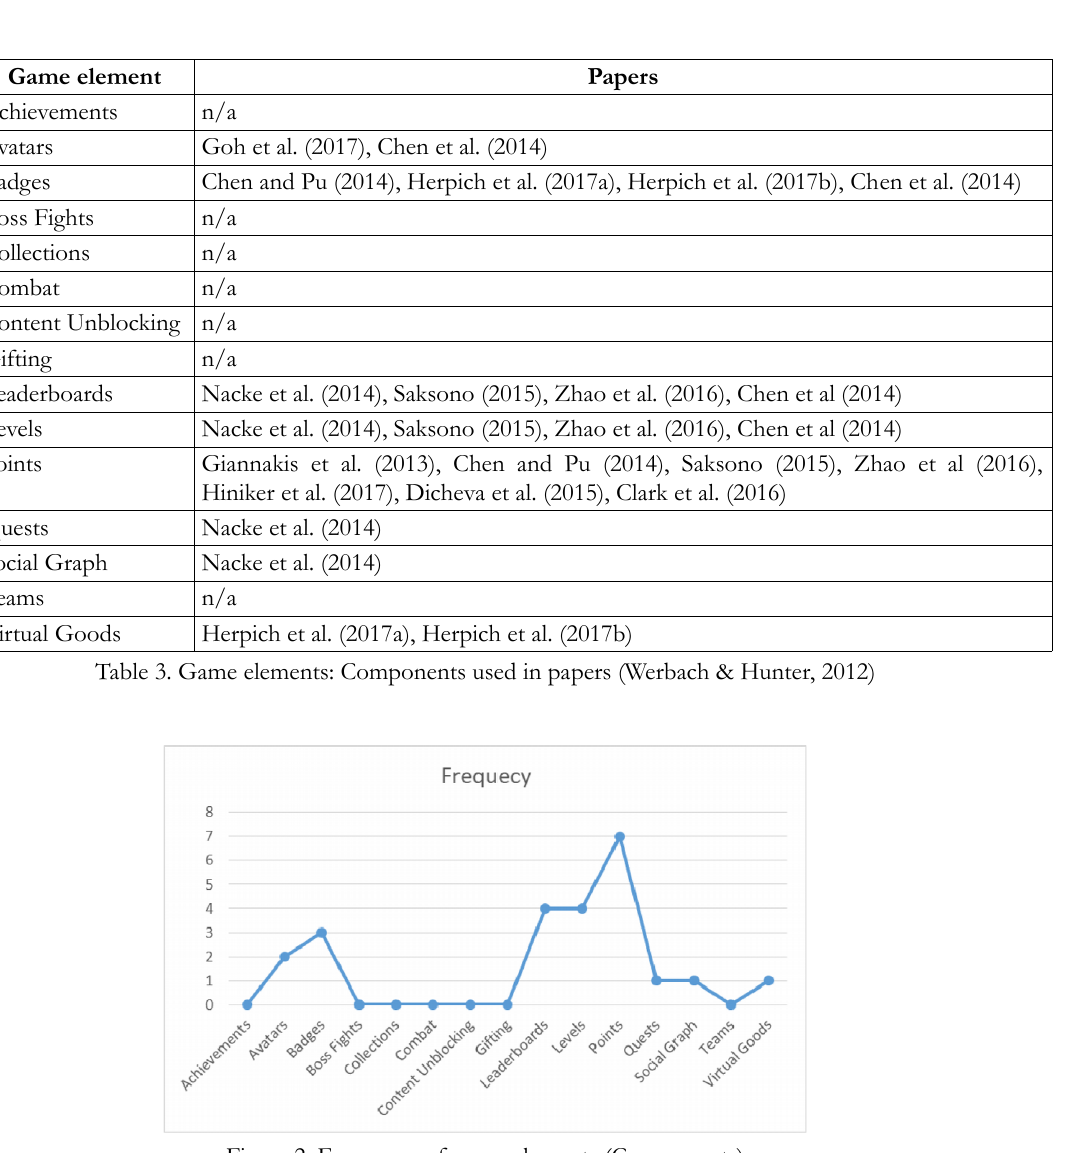
Figure 2. Frequency of game elements